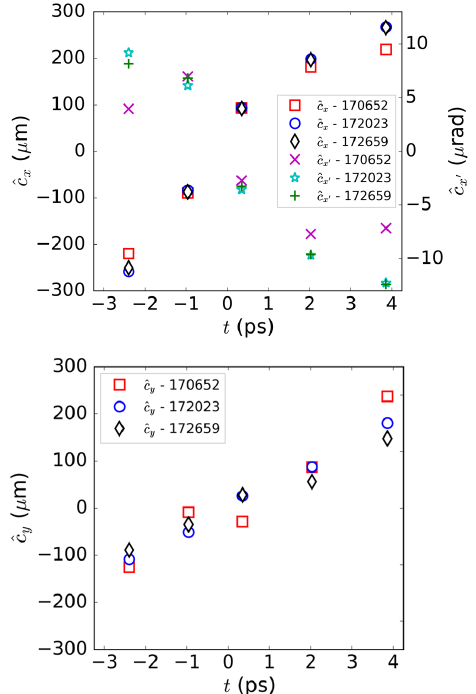
FIG. 16. Measured misalignments of each bunch in the train for the No. 170652, No. 172023, and No. 172659 experiments. The bunch train head is on the